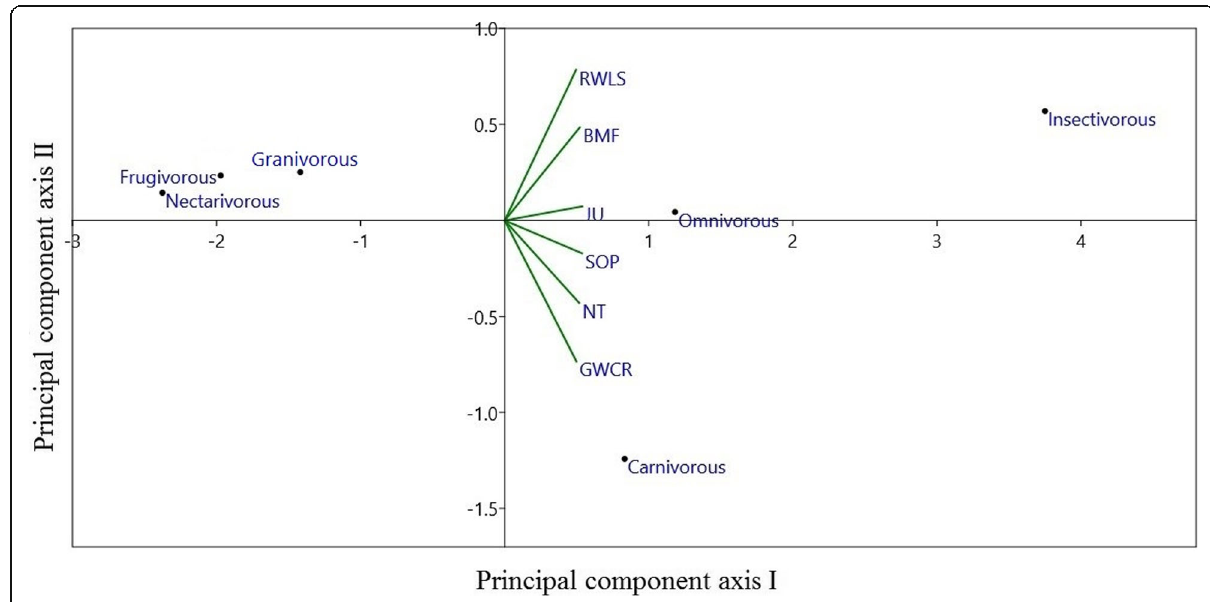
Fig. 7 Representation of bird feeding guilds corresponding to habitat types along two principal component axis among the study